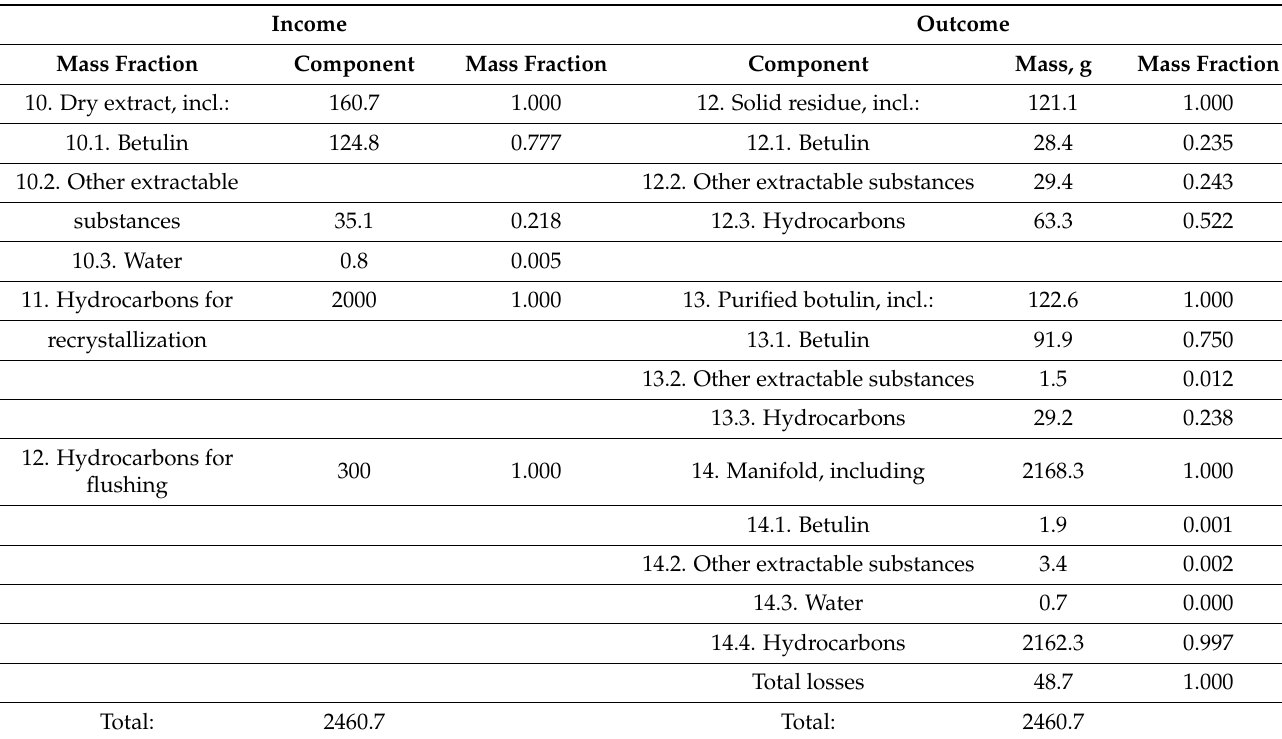
Table 7. Material balance of the recrystallization process of the